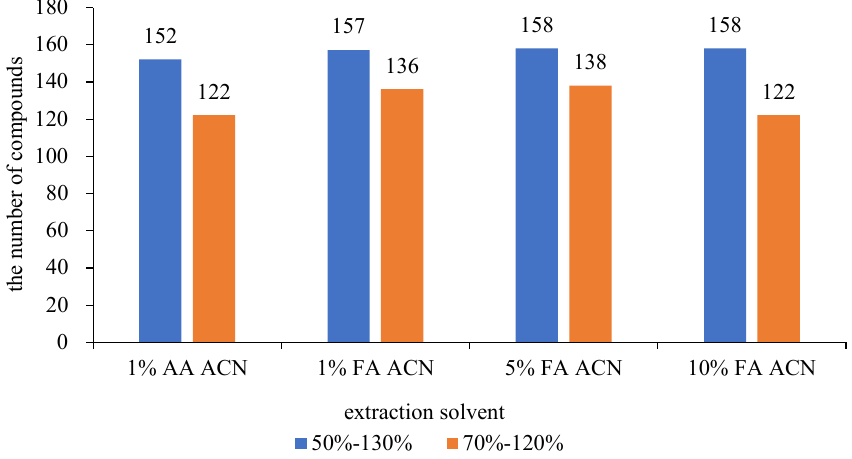
Figure 2. The number of compounds with recoveries between 50 and 130 (%) and 70 and 120 (%) using different extraction solvents. Abbreviations: AA: acetic acid, FA: formic acid, ACN: acetoni- trile.